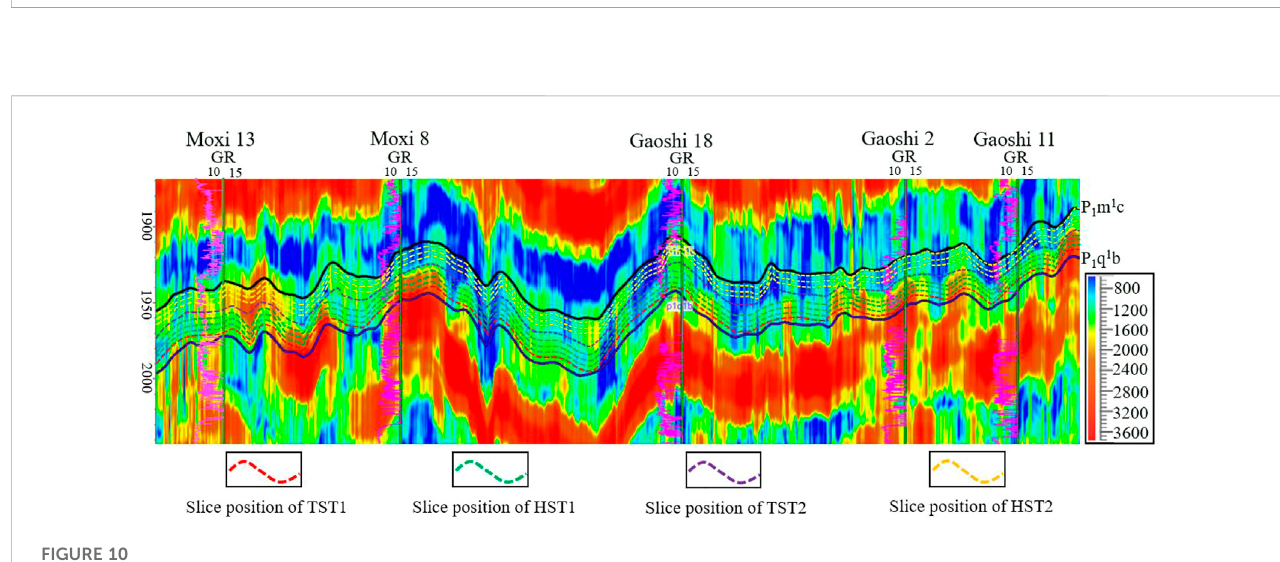
Comparison chart of attribute optimisation slices during HST1 in the study area: (A) instantaneous amplitude attribute; (B) instantaneous frequency attribute; (C) instantaneous phase attribute; (D) dessert attribute; (E) curvature attribute; and (F) root mean square amplitude attribute.